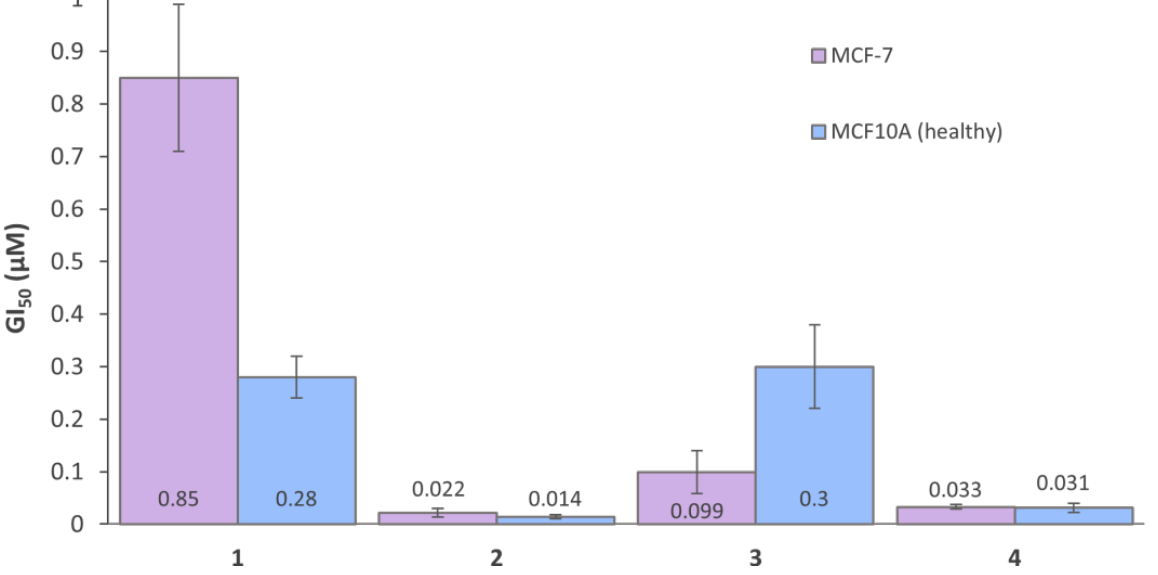
Figure 9. The GI 50 values of 1 – 4 against MCF-7 (breast cancer) and MCF10A (healthy breast) cell lines. Complexes were incubated for 72 h. GI 50 values (µM) are the mean and reported with standard error of the mean; produced from three independent experiments. Pharmaceutics 2022 , 14 , x FOR PEER REVIEW